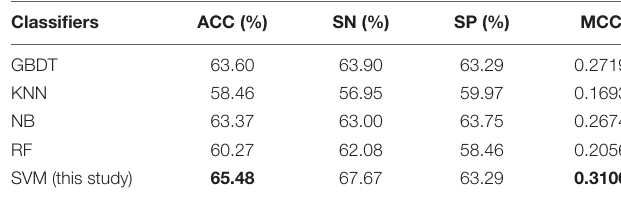
TABLE 3 | Comparative results of SVM and four well-known classifiers on the dataset used in this study.